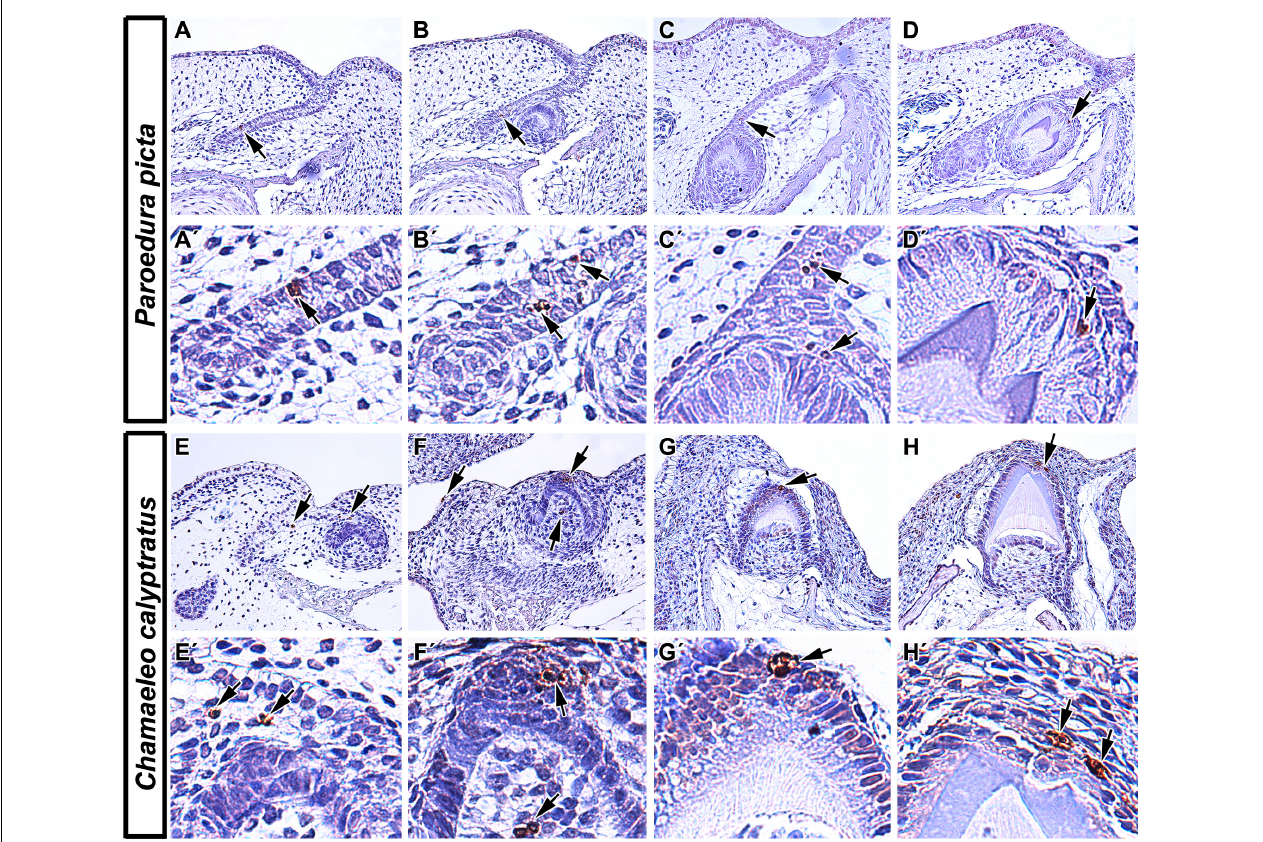
FIGURE 2 | Localization of apoptotic cells in squamate teeth. (A–D) Detection of apoptotic cells in developing tooth germs of Ocelot gecko ( Paroedura picta ). (A,A (cid:48) ,B,B (cid:48) ) TUNEL-positive cells were found both in the epithelium of interdental dental lamina and in successional dental lamina, indicating their role not only in the growth of tooth germs but also in continuous tooth replacement (black arrows). (C,C (cid:48) ) Apoptotic cells were also situated in the stellate reticulum of the developing tooth and in the EK-like cluster of cells (black arrows). (D,D (cid:48) ) Later in development, TUNEL-positive cells were mostly situated above the enamel ridge (black arrow). (E–H) Presence of TUNEL positive cells during different stages of odontogenesis in Veiled chameleon ( Chamaeleo calyptratus ). (E) Apoptotic cells appear in the presumptive stellate reticulum of early cap stage tooth germ (E (cid:48) ) and in the labially situated, developing salivary glands. (F,F (cid:48) ) Later, clustering of TUNEL positive cells takes place in the EK-like area of the cap stage tooth germ, with few apoptotic cells found in the adjacent mesenchyme (F) . (G,G (cid:48) ,H,H (cid:48) ) Once odontogenesis proceeds and hard tissue production has begun, there are a few TUNEL-positive cells located at the top of the forming ridge, delimiting the margins of developing enamel grooves. TUNEL-positive cells (brown, DAB), TUNEL-negative cells (blue,